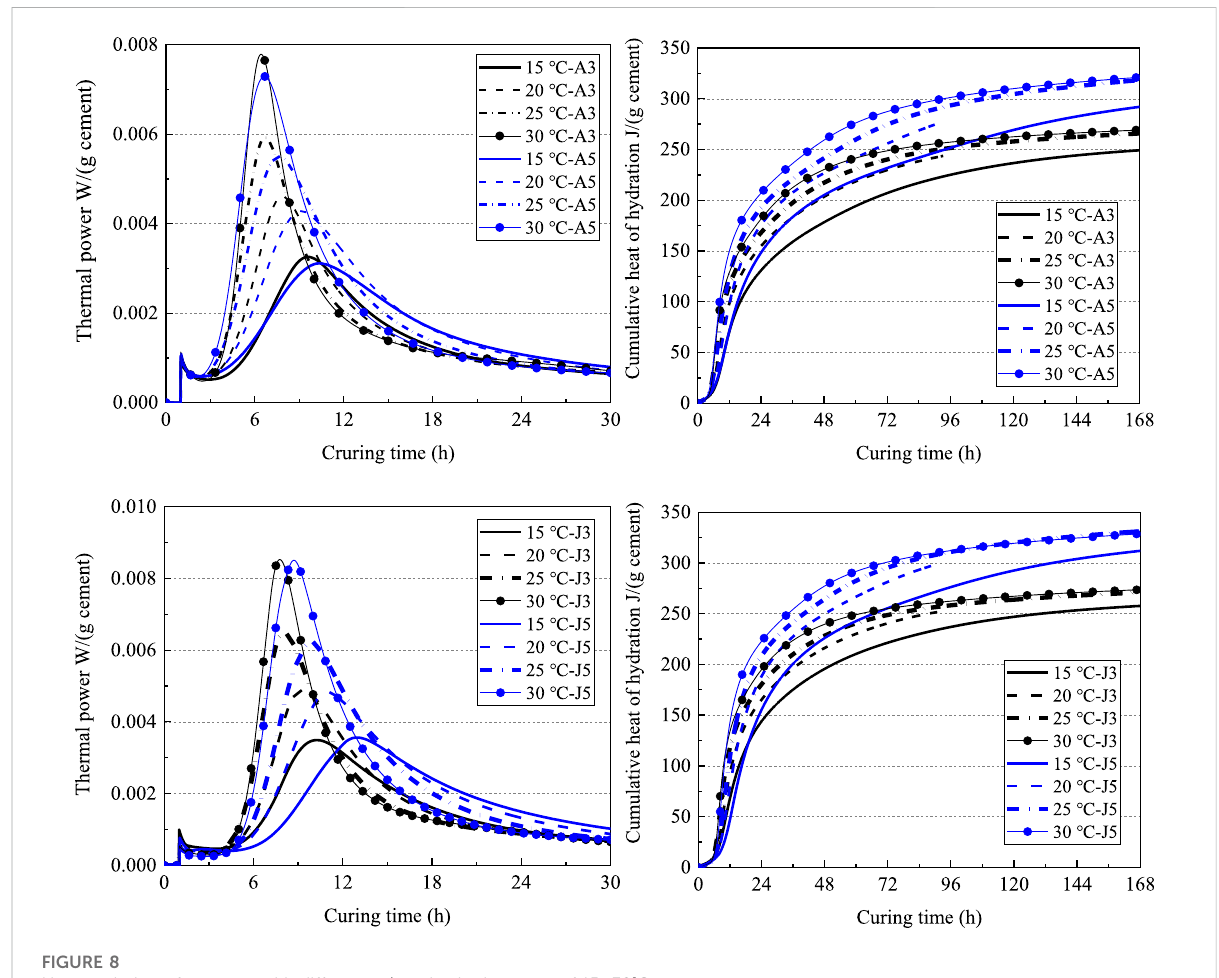
FIGURE 8 Heat evolution of cements with different w/c ratios in the range of 15 – 30 °